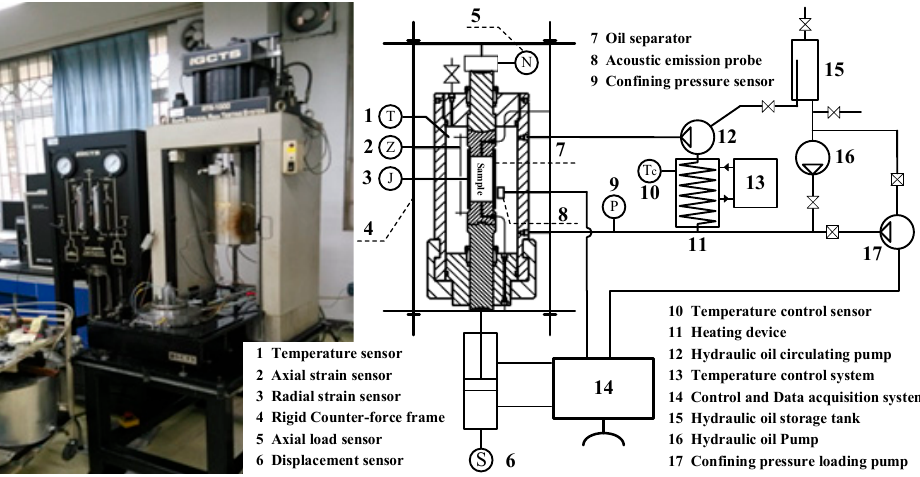
Figure 12. Triaxial mechanics testing system (RTR-1000) of caprock. Rock mechanics test results of mudstone caprock of two wells in the adjacent